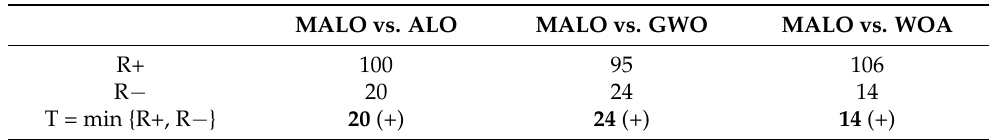
Table 14. The t values of significance test on averaged g-mean between MALO vs. ALO, MALO vs. GWO, and MALO vs. WOA.